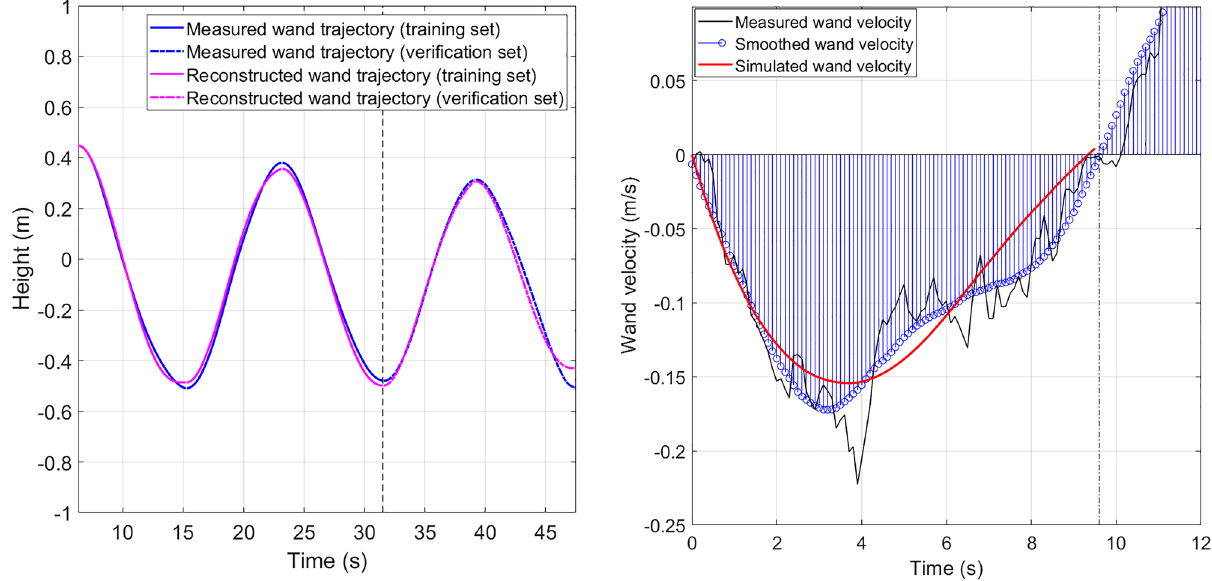
Figure 3. ( Left ): Comparison between the measured and the simulated wand trajectory. ( Right ): Comparison between the measured wand velocity computed from differentiating the trajectory data, the smoothed wand velocity, and the simulated velocity (dataset 5).